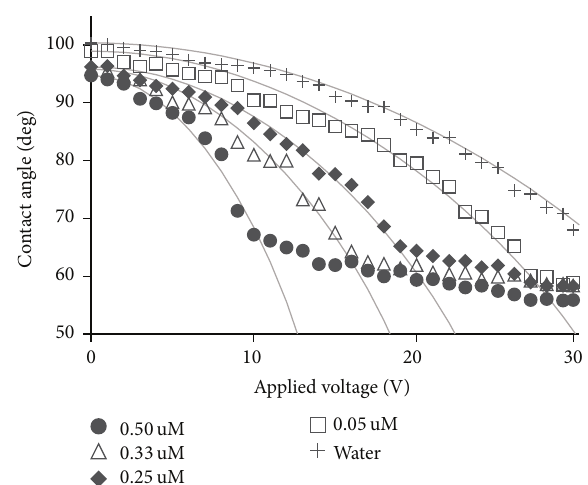
Figure 5: Contact angle versus applied voltage for droplets of dif- ferent AuNP concentrations. The solid lines represent the expected quadratic dependence of contact angle on voltage. Higher concen- trations reduce voltage requirements for effective